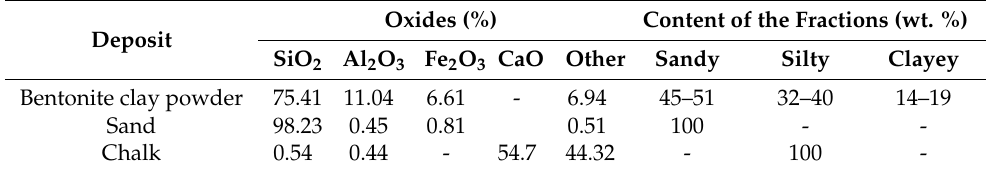
Table 1. Chemical content and fractions of the MM components.